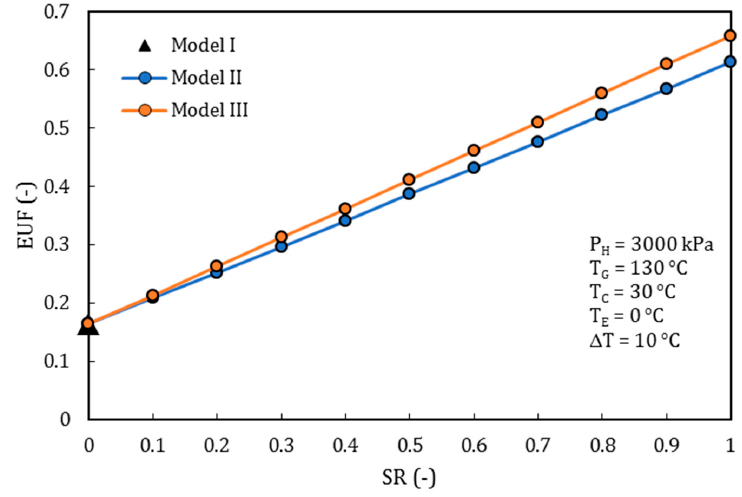
Figure 16. Comparison of the EUF as a function of SR for the three models.